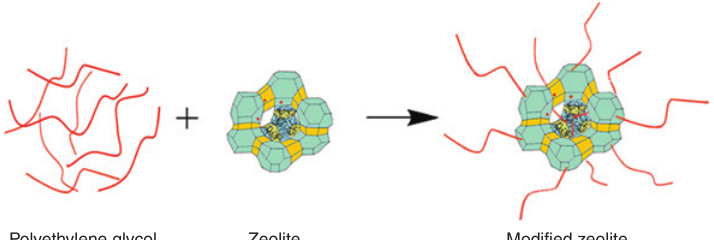
Figure 1 Mechanism of PEG-modified